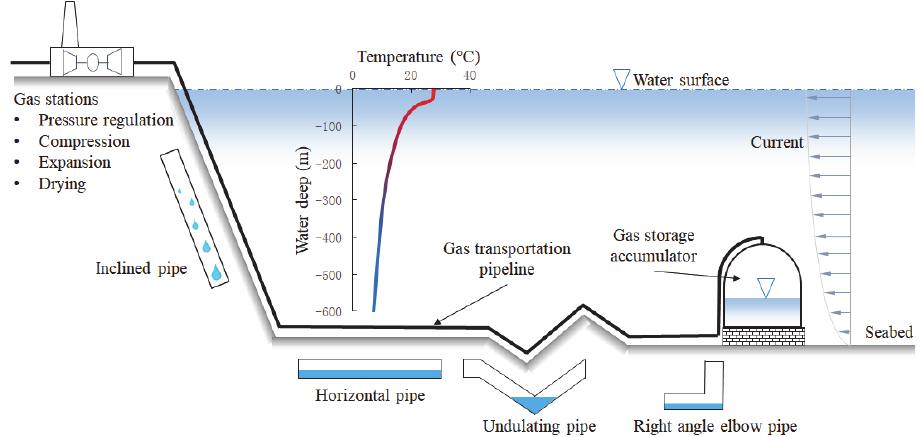
Figure 5. Schematic diagram of underwater gas transportation system.